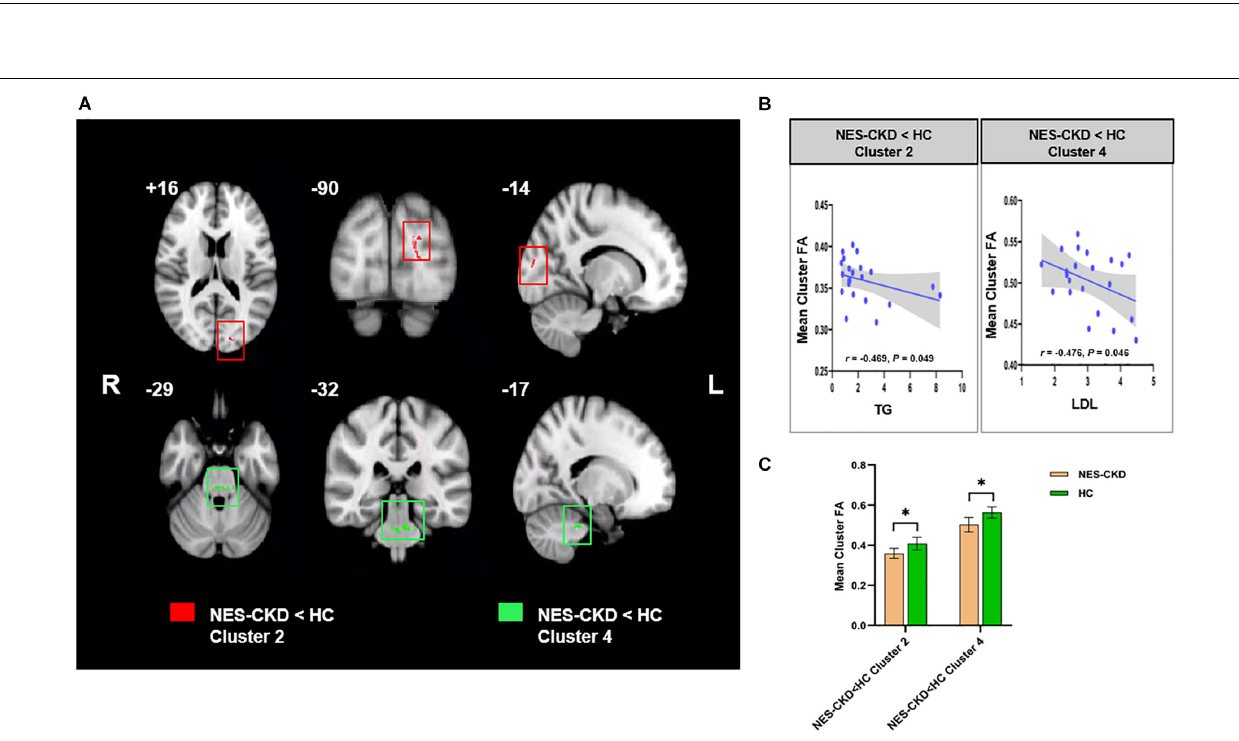
Frontiers in Human Neuroscience |